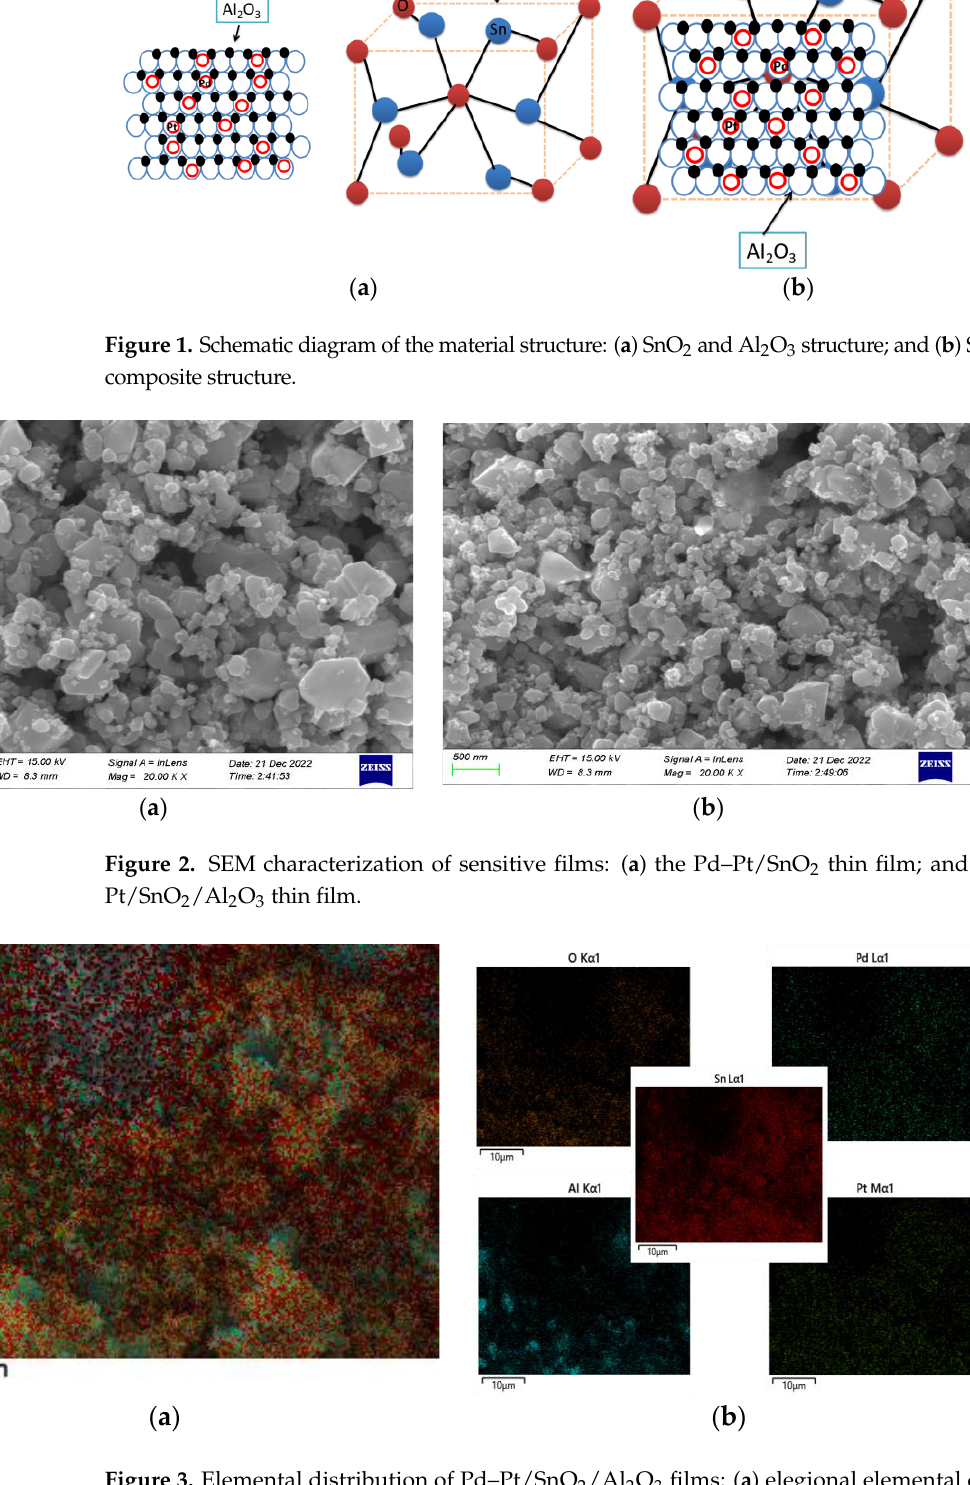
Figure 3. Elemental distribution of Pd – Pt/SnO 2 /Al 2 O 3 films: ( a ) elegional elemental distribution maps; and ( b ) single elemental distribution maps.